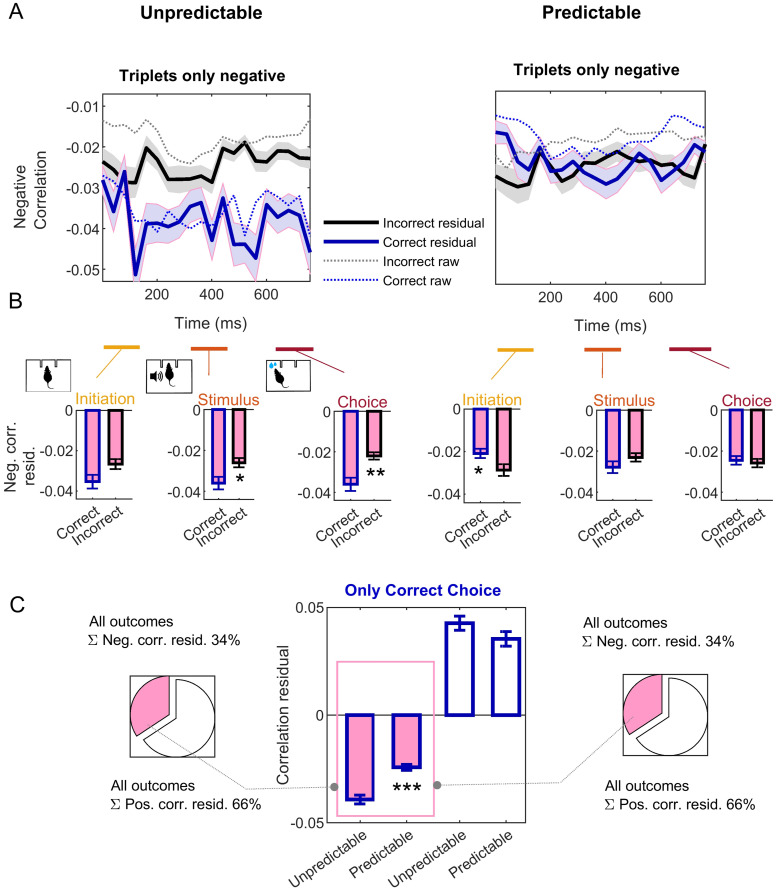
Correlation of the residuals of a linear regression adjustment with the preceding trial.Partial (residual) negative trial averaged, triplet-wise correlations accompany the unsuccessful decoding of correct choices for unpredictable stimuli. (A) Negative correlations among triplets after correct (unpredictable, left) and after incorrect (predictable, right) trial choice outcomes, averaged across all ensembles recorded. Correct choices are shown in blue, incorrect choices in black; shaded areas are SD. Solid lines indicate the partial correlation coefficients; that is, correlations among the residual firing-rates after being regressed with the immediately previous trial rates (like in S3 Fig), see Data analysis section in Materials and methods. Dashed lines indicate the raw triplet-wise correlations shown in Fig 6A for comparison. Like in Fig 6, magenta filling is used though the figure to indicate negative partial correlations. (B) Averages for the periods of interest defined in Fig 1: trial initiation (left), stimulus offset (central) and choice (right). Signed-rank tests, p < 0.0036. (C) Average partial triplet-wise correlations only for correct choices (comparison of unpredictable versus predictable negative partial correlations, Wilcoxon rank sum, W = 141540, p = 6.8 ⋅ 10−6). Left and right pie charts show the total fraction of partial positive and negative correlations for all ensembles and trials. * p < 0.01, ** p < 0.001, *** p < 0.0001. See also Fig 6 for raw triplet-wise correlations, and S4 Fig for raw and partial pairwise correlations.